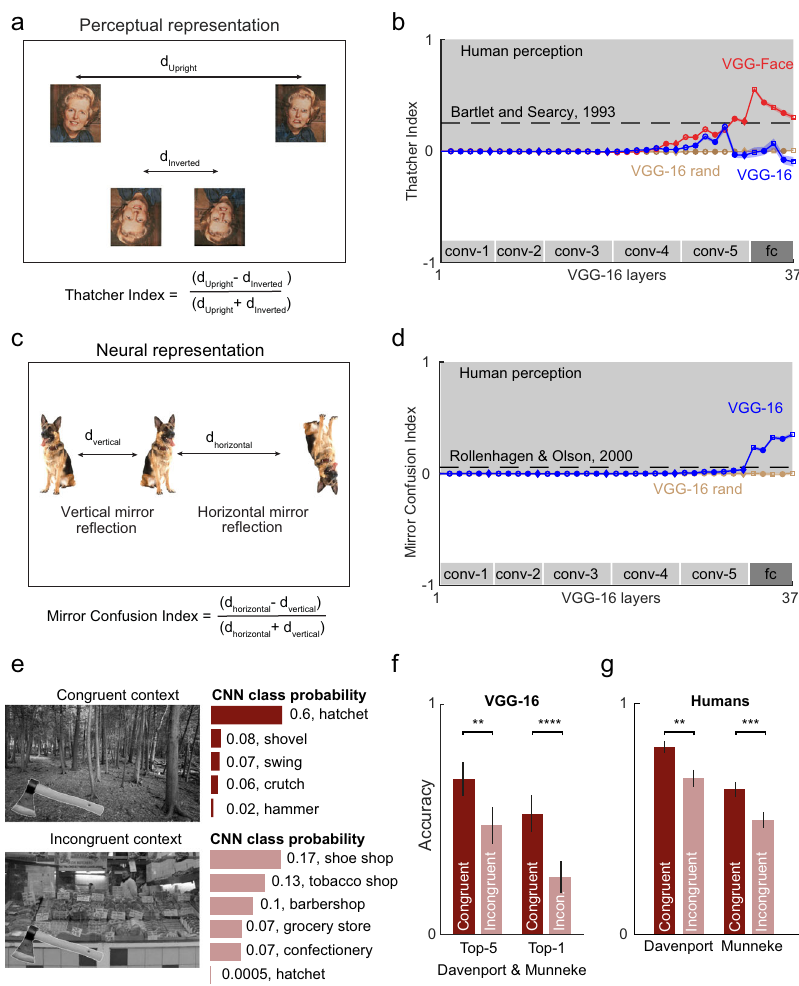
Fig. 2 Object and scene regularities in deep networks. a Perceptual representation of normal and Thatcherized faces in the upright and inverted orientations. b Thatcher index across layers of deep networks. For deep networks, we calculated the Thatcher index using Thatcherized faces from a recently published Indian face dataset (see the “ Methods ” section) across layers for the VGG-16 ( blue ), VGG-face ( red ), and a randomly initialized VGG-16 ( brown ). Error bars indicate s.e.m. across face pairs ( n = 20). The grey region indicates human-like performance. Dashed lines represent the Thatcher index from a previous study 14 , measured on a different set of faces (see the “ Methods ” section). c Neural representation of vertical and horizontal mirror images. Vertical mirror image pairs are closer than horizontal mirror image pairs. d Mirror Confusion Index (averaged across all objects) across layers for the pretrained VGG-16 network ( blue ) and a VGG-16 network with random weights ( brown ). Error bars indicates s.e.m. across stimuli ( n = 50). Dashed lines represent the mirror confusion index estimated from monkey inferior temporal (IT) neurons in a previous study 18 . e An example object ( hatchet ) embedded in an incongruent context ( forest ) and in a congruent context ( supermarket ). The class probability returned by the VGG-16 network is shown beside each image for the top fi ve guesses and for the correct object category (hatchet). f Accuracy of object classi fi cation by the VGG-16 network for congruent ( dark ) and incongruent ( light ) scenes, for top-5 accuracy ( left ) and top-1 accuracy ( right ). Error bars represent s.e.m. across all scene pairs (n = 40). Asterisks indicate statistical signi fi cance computed using the Binomial probability of obtaining a value smaller than the incongruent scene correct counts given a Binomial distribution with the congruent scene accuracy (** is p < 0.01, **** is p < 0.001). g Accuracy of object naming by humans for congruent (blue) and incongruent (red) scenes across two separate studies 19,20 . Error bars and statistical signi fi cance are taken from these studies (Davenport Set: ** indicates p < 0.01 for the main effect of congruence in a within-subject ANOVA on accuracy; Munneke Set: *** indicates p = 0.001 for accuracy in paired t